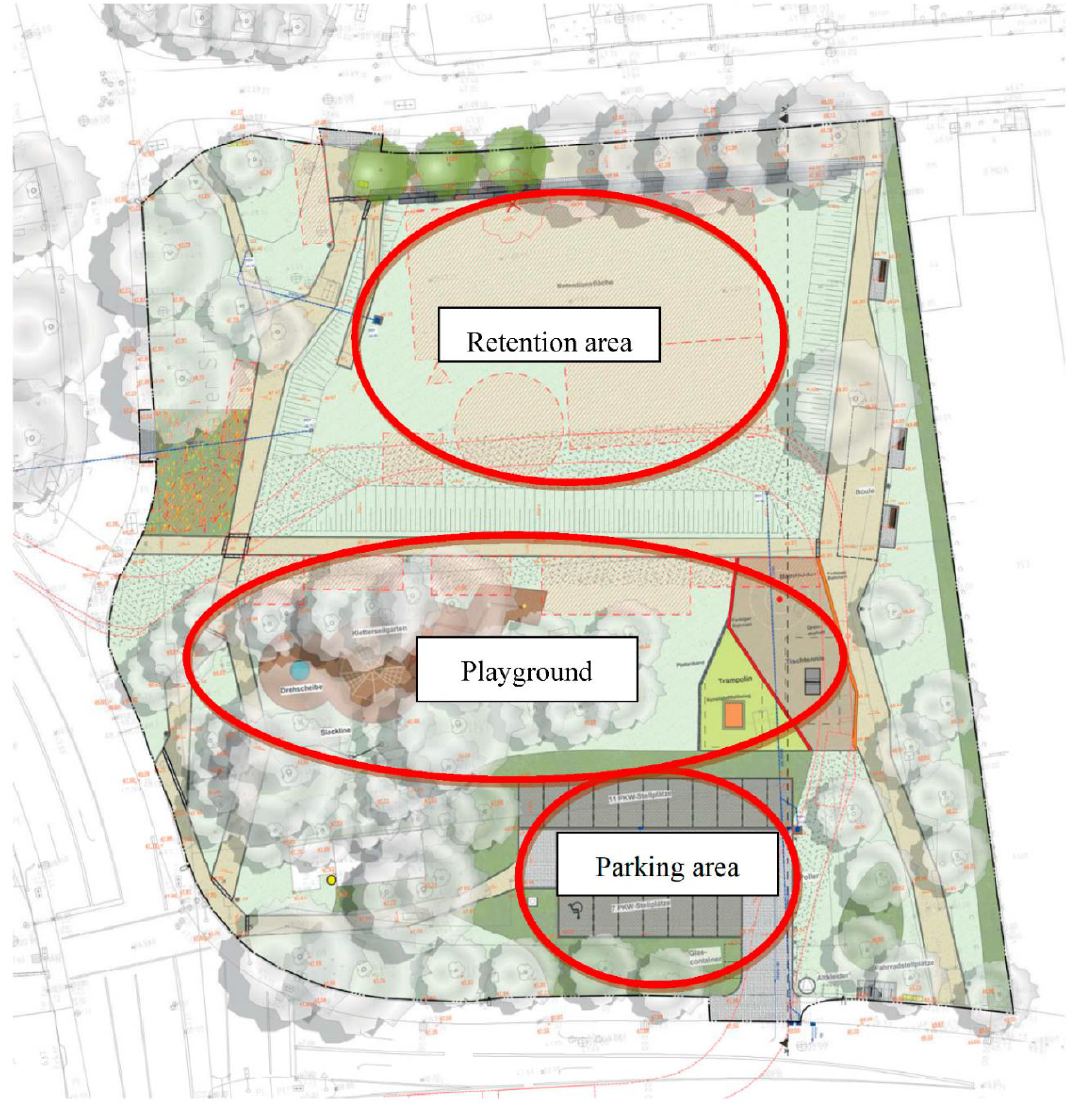
Figure 4. Planning design of the water plaza [35].